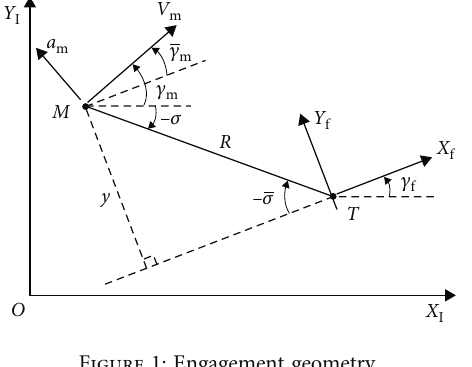
Figure 1: Engagement geometry.